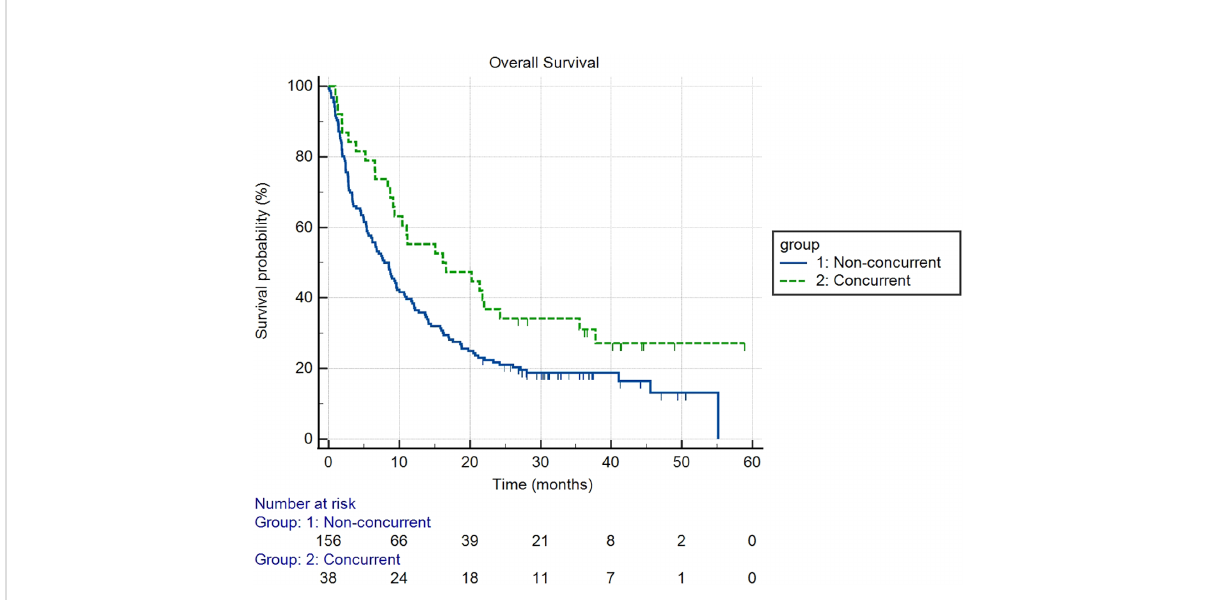
FIGURE 5 Kaplan-Meier survival analysis of the overall survival between the non-concurrent RT+ICI and concurrent RT+ICI. There was no signi fi cant difference in overall survival between the two groups